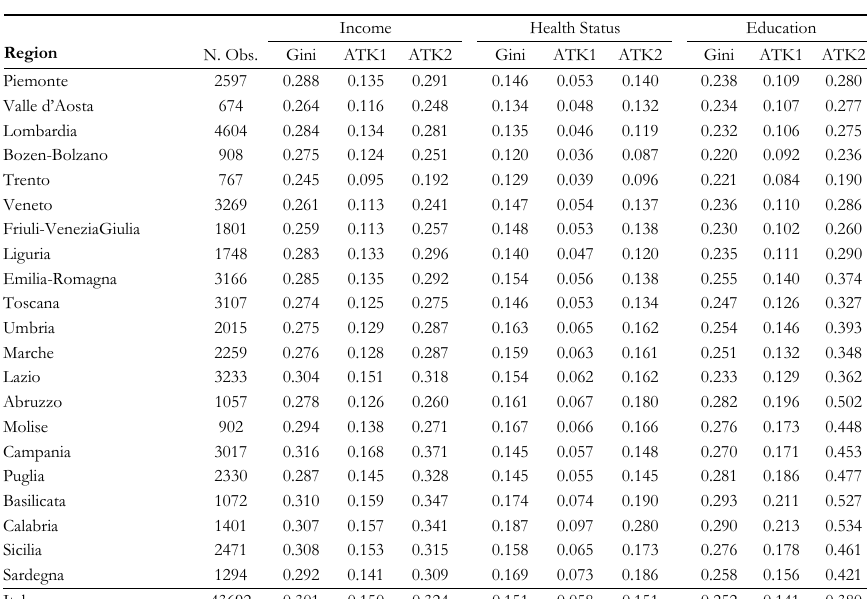
Univariate inequality measures by region (year